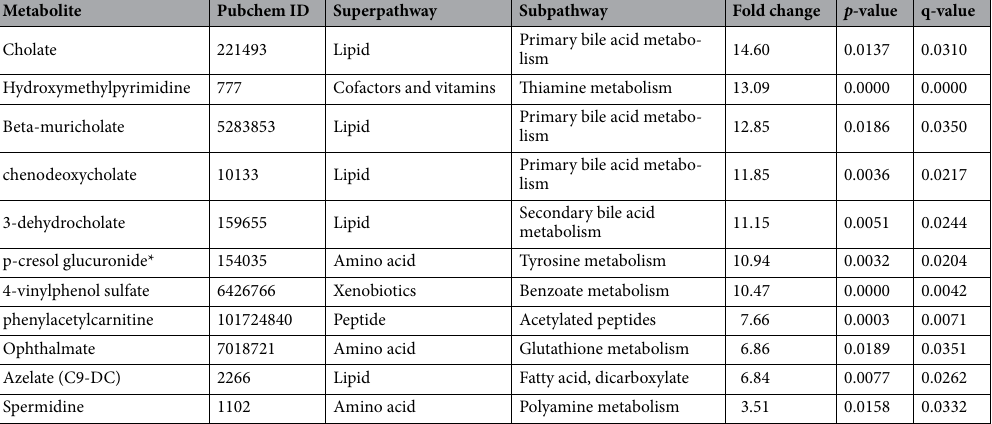
Table 1. Elevated metabolites in the Ahr knockout cover a wide range of biochemical pathways, with many showing fold changes greater than 2.